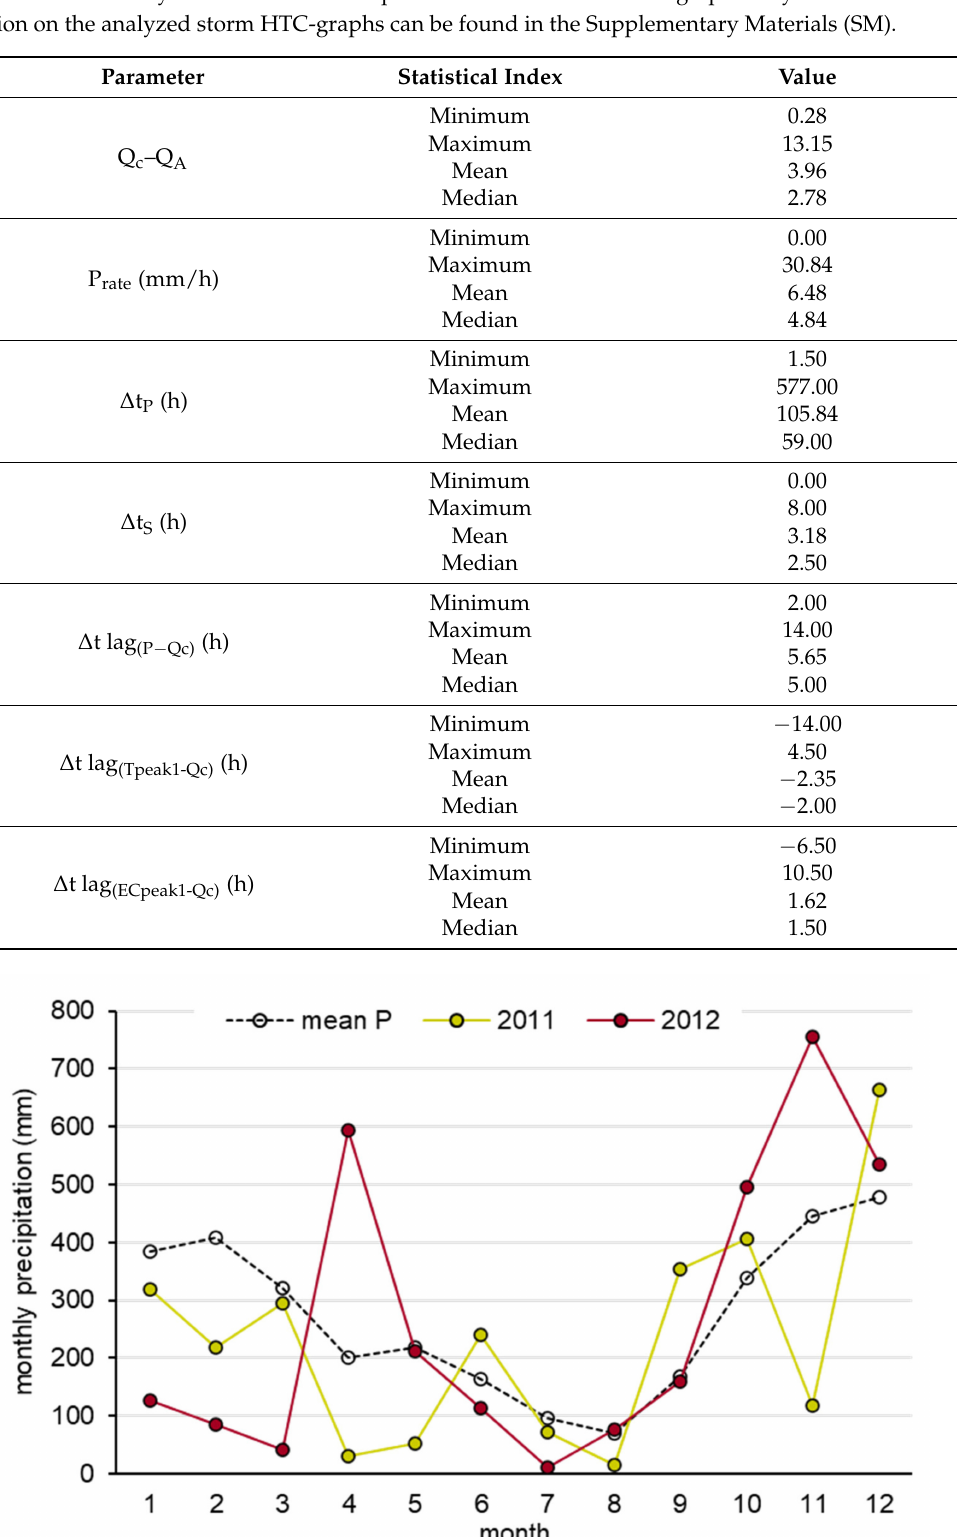
Figure 5. Comparison between the mean monthly precipitation (2010–2020) and the monthly values for the 2011 and 2012 years. Data were collected by the Campagrina meteorological station (station code: TOS02000241; https://www.sir.toscana.it/consistenza-rete, accessed on 1 December